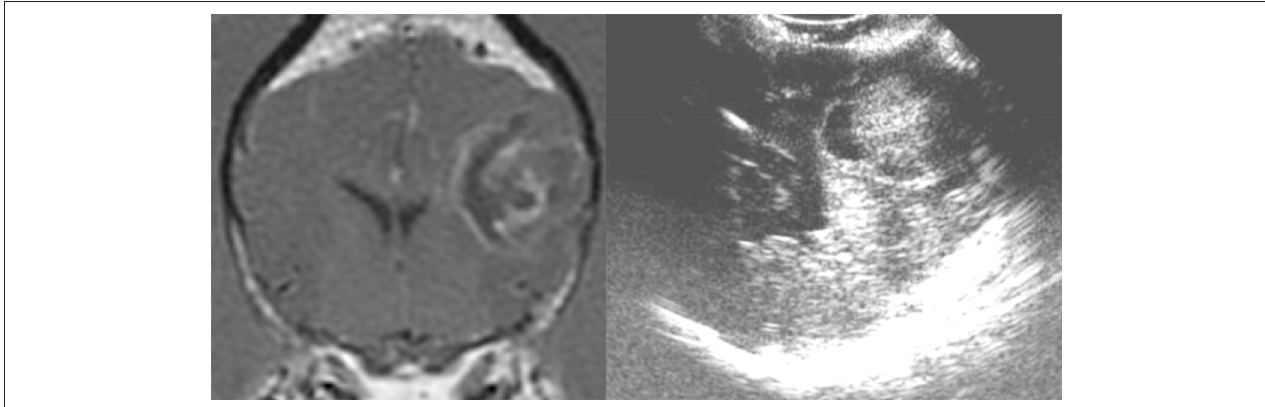
FIGURE 2 | Case 24. There is an ovoid, well-circumscribed, 1.65cm by 1.80cm (MRI)/1.83 × 1.75cm (US), heterogeneous, centrally hyperechoic and rim hypoechoic mass present in the right cerebrum, which results in medial displacement of the ultrasonographically normal brain parenchyma. There are a few pockets of anechoic fluid present medial and caudal this mass. This mass was a high-grade oligodendroglioma.